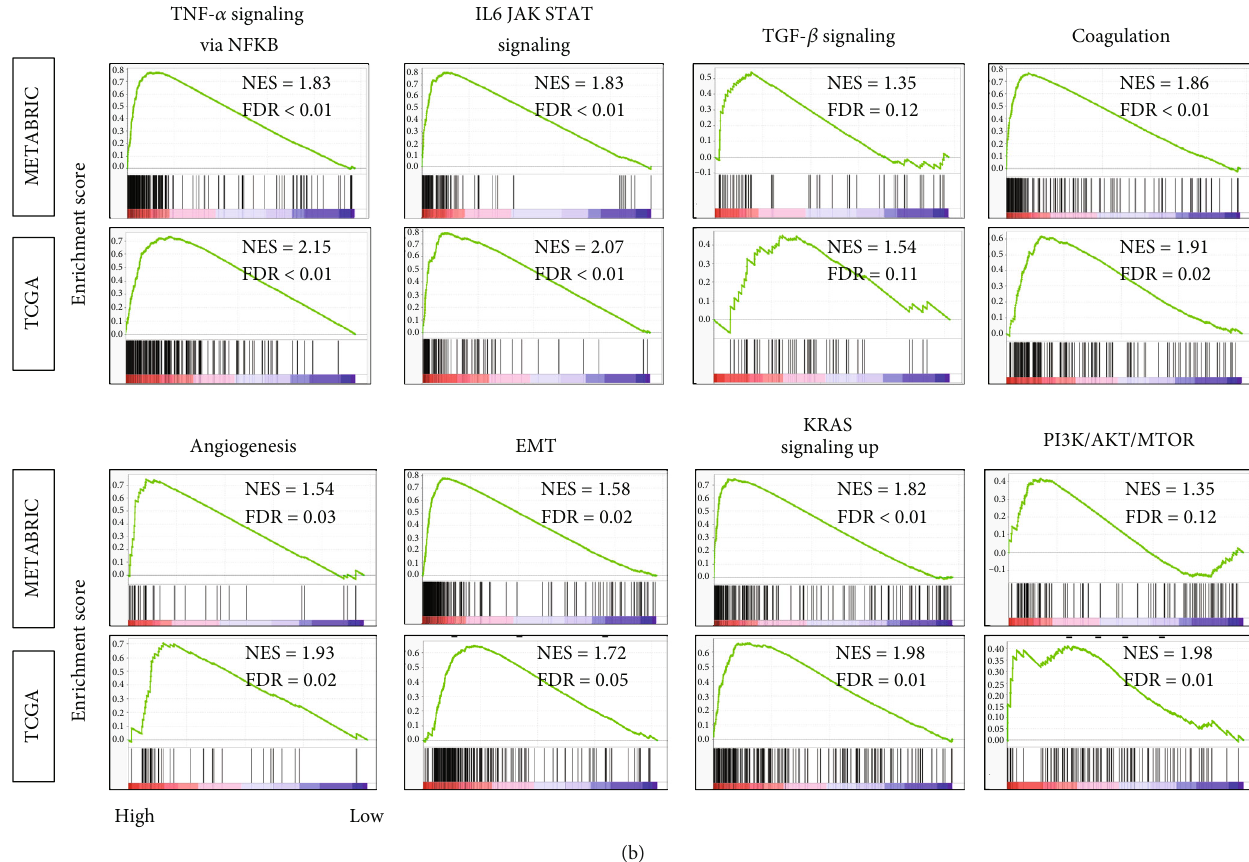
Figure 3: Gene Set Enrichment Assay (GSEA) of high in fl ammatory pathway score in triple-negative breast cancer. Enrichment plots are shown for (a) favorable immune-related and (b) unfavorable Hallmark gene sets for which highly enriched in the high in fl ammatory pathway score compared to low-score group in both the TCGA and METABRIC cohorts, along with normalized enrichment score (NES) and false discovery rate (FDR). The statistical signi fi cance of GSEA was determined using FDR of